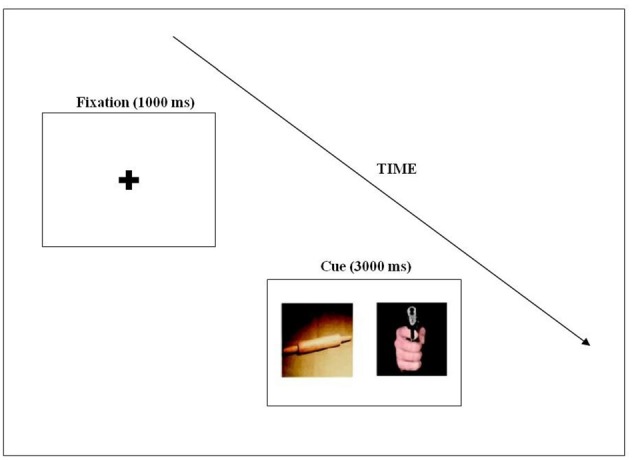
An example of the stimulus pairs used in the eye-tracking experiment, and an illustration of the trial structure.